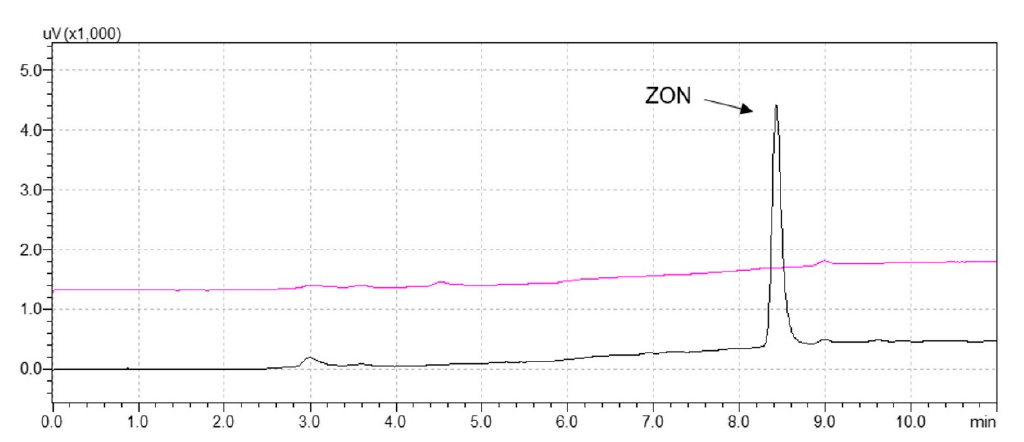
Figure 2. Chromatograms of elution fractions obtained by loading 3 mL of diethyl ether spiked at level of 125 ng/mL after the NIP - (pink trace) and MIP - solid-phase extraction (SPE) (black trace) clean-up procedures; ZON = zearalenone.